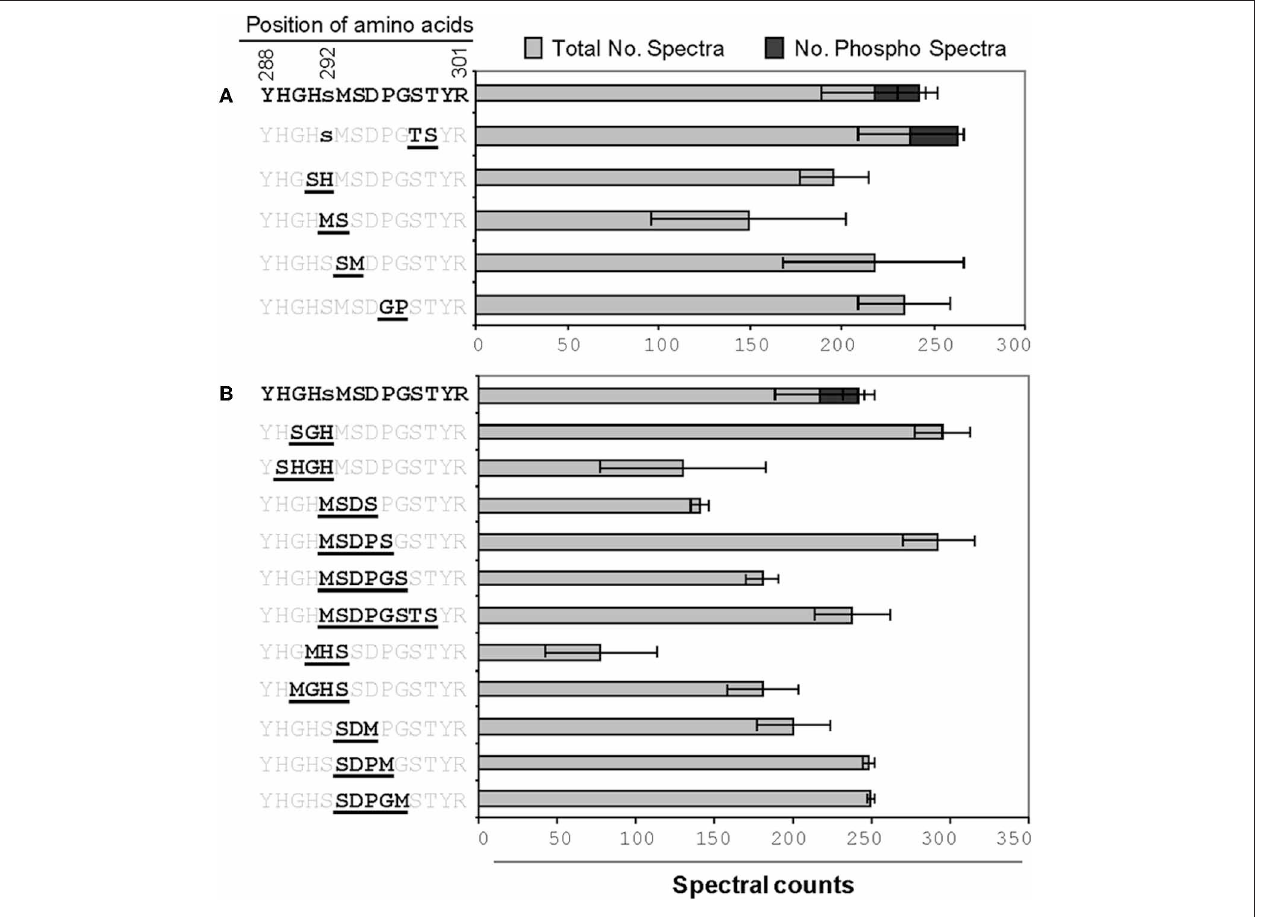
sites of change. A lower case letter indicates a potential phosphorylation site. The spectral count data presented are means of three technical replicates each for both phosphorylated and non-phosphorylated